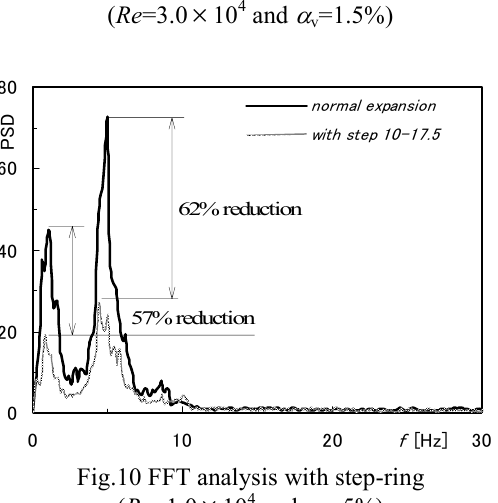
Fig.10 FFT analysis with step-ring ( Re =1.0 × 10 4 and α v